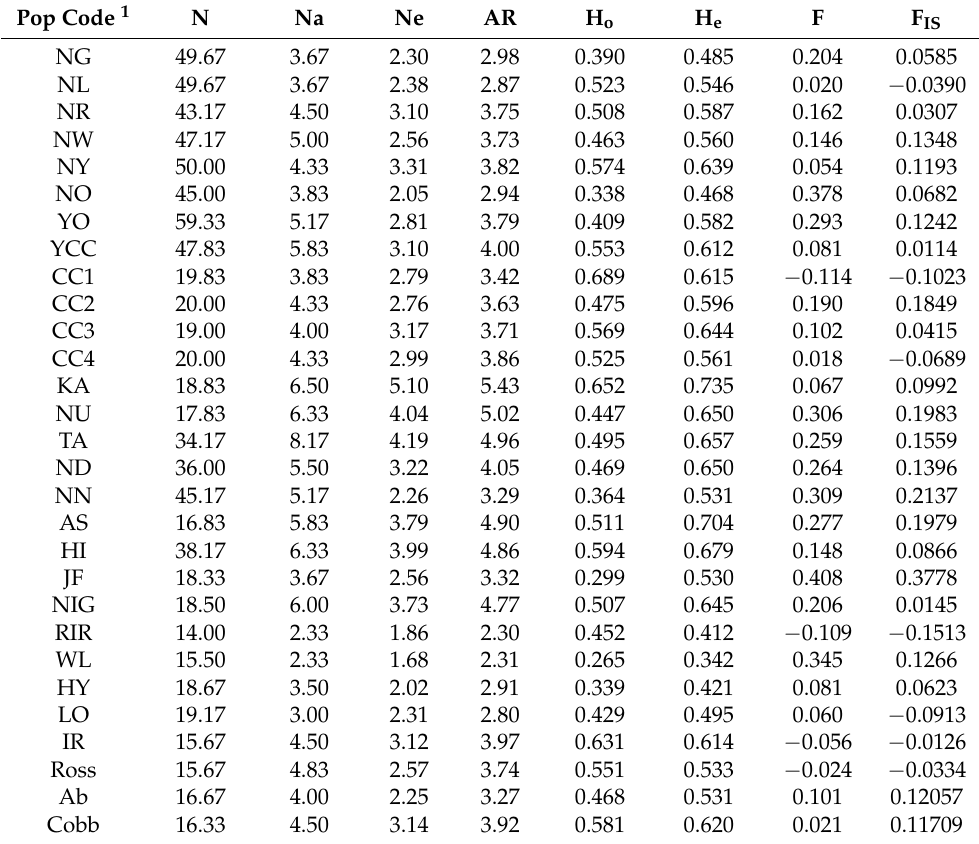
Table 3. Mean allele number, allele richness, observed and expected heterozygosity values for Set 2 microsatellite markers in 29 populations.